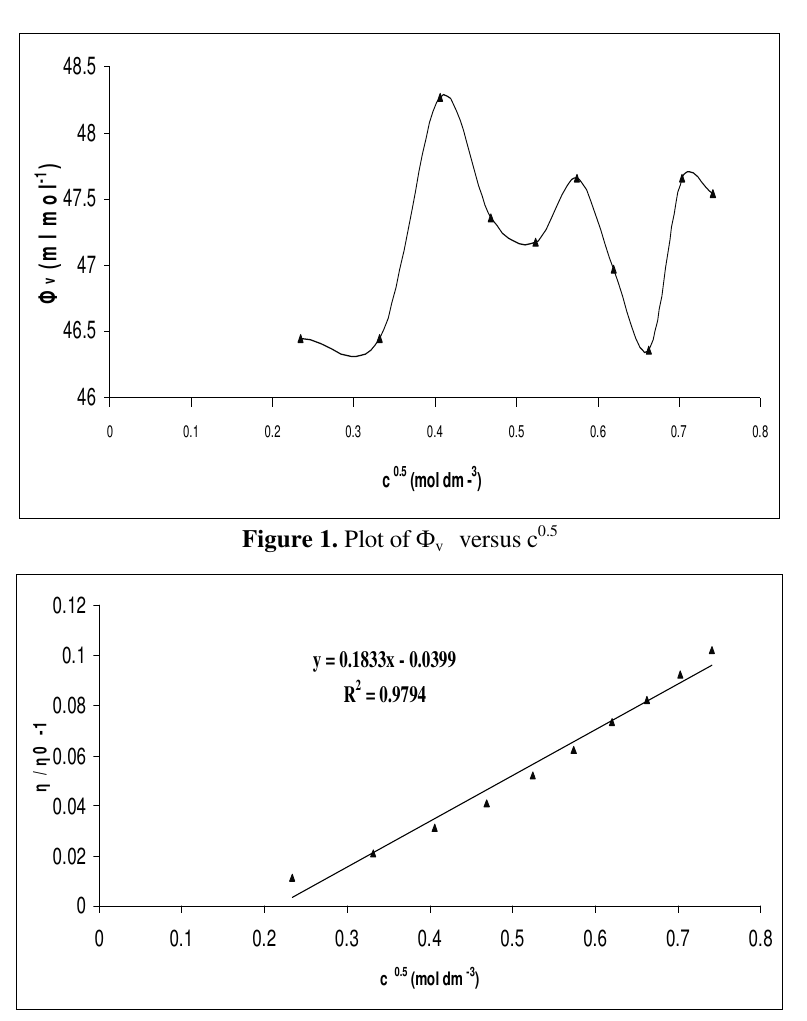
Figure 2. Plot of concentration versus ( (cid:5) / (cid:5) 0